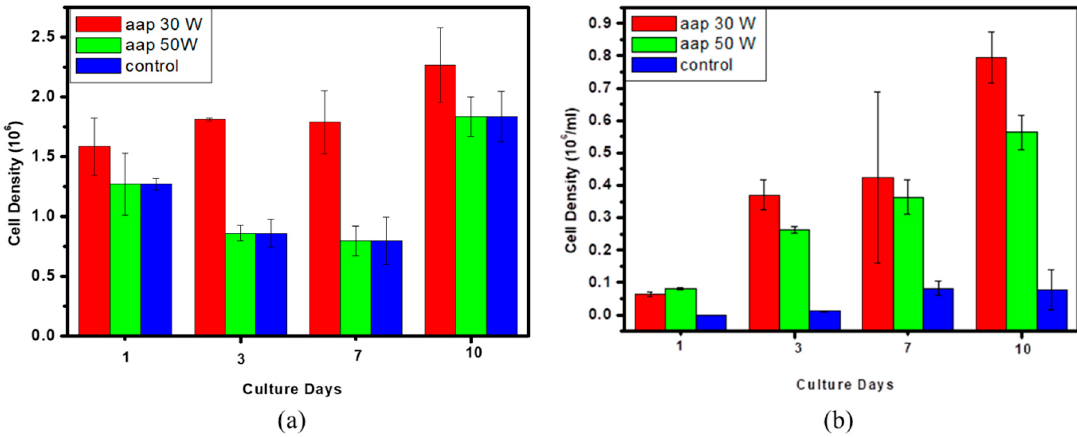
Figure 7. Cell density of ES cells for in vitro cytocompatibility assay for days 1, 3, 7 and 10 for the PP nonwoven and PLGA without and with the acetic acid films deposited at different plasma powers. ( a ) PP nonwoven ( b ) PLGA